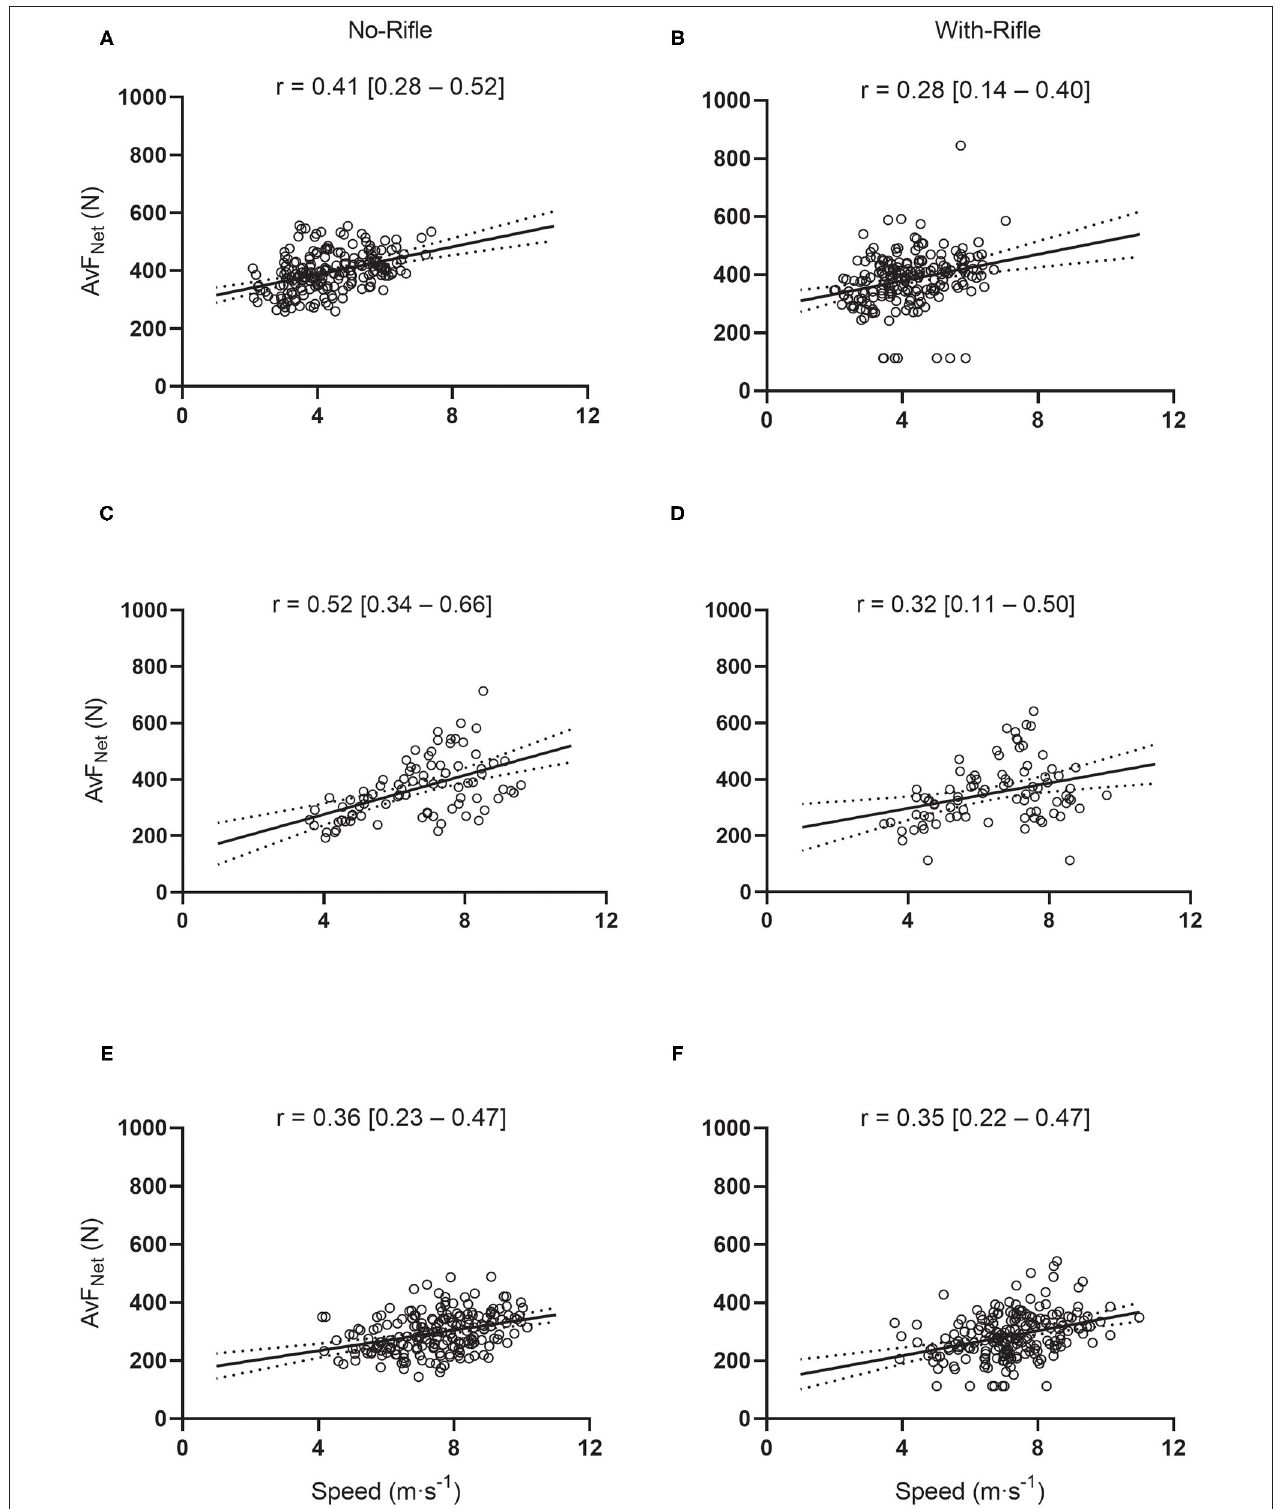
FIGURE 7 | Scatterplots displaying relationships between Average Net Force and skiing speed during Uphill, Flat and Downhill gradients with and without the biathlon rifle. Each dot represents an individual speed (x) vs. Average Net Force (y) (for the pelvis sensor) for every Uphill (A,B) , Flat (C,D) and Downhill (E,F) section. Panels on the left are for No-Rifle; Panels on the right are for With-Rifle. Pearson correlation coefficient ( r ) with 95% confidence interval shown.